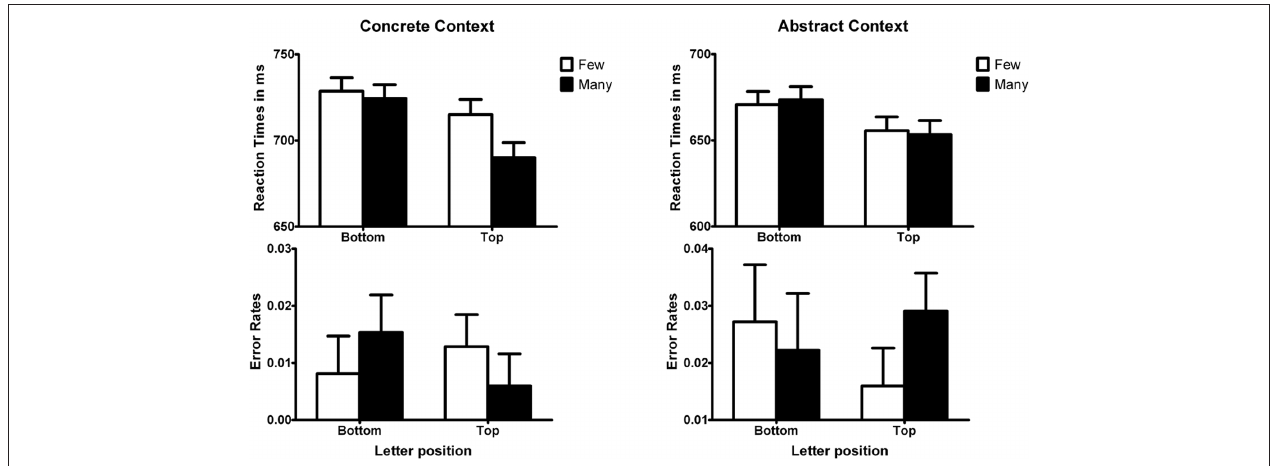
Figure 1 | reaction times and error rates for the letter identification task in experiments 1 (Concrete Context) and 2 (Abstract Context). Error bars represent standard error of the mean difference for